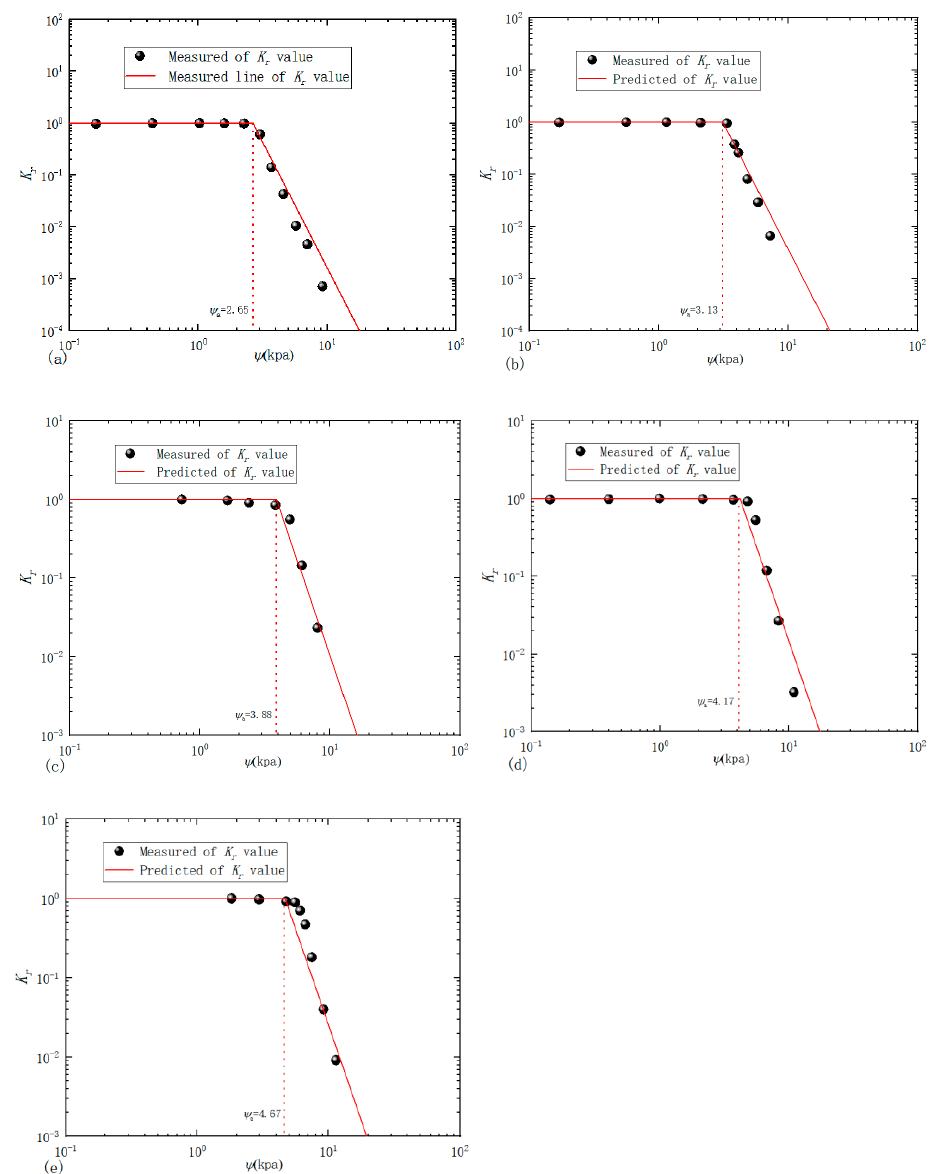
Figure 5. Prediction results of the unsaturated relative permeability coefficients of Columbia sandy loam with different void ratios: ( a ) e = 1.268; ( b ) e = 1.114; ( c ) e = 0.942; ( d ) e = 0.89; ( e ) e = 0.815.